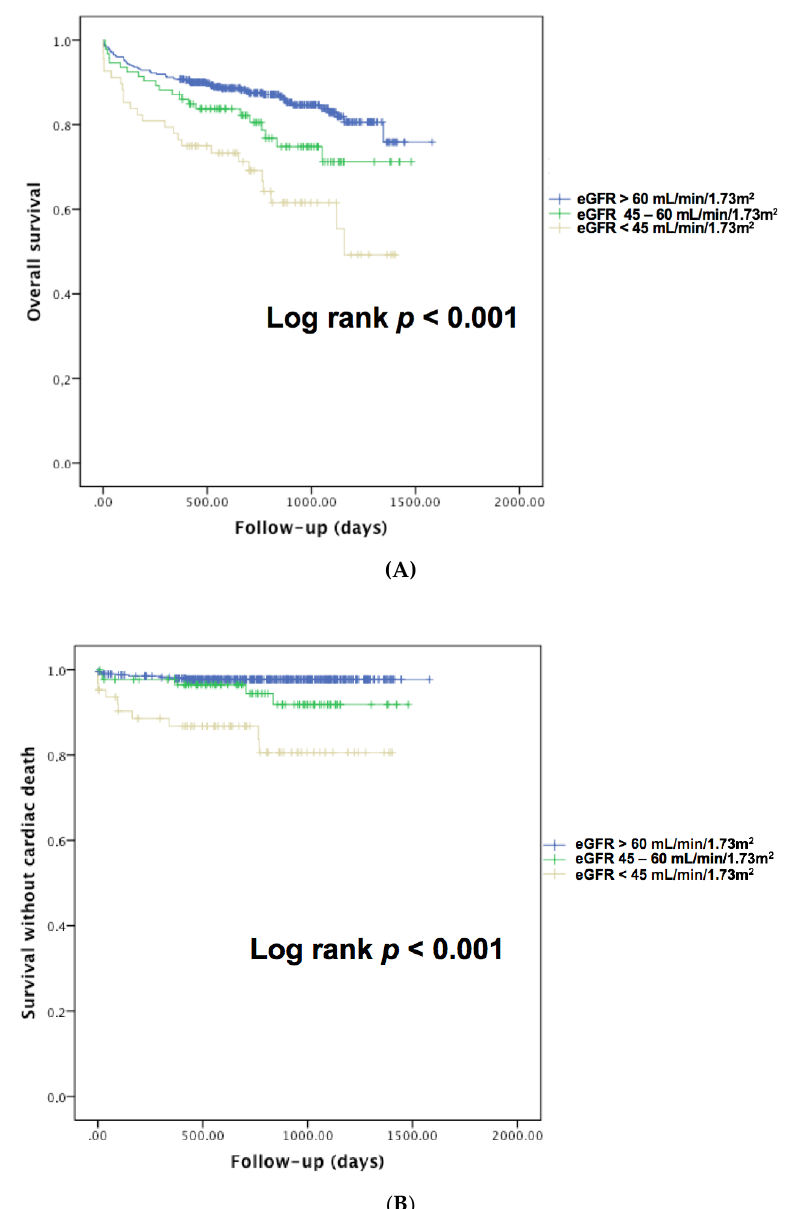
Figure 2. (A) Kaplan–Meier analysis for the probability of overall survival according to renal dysfunction in patients with acute pulmonary embolism. ( B ) Kaplan–Meier analysis for the probability of cardiac survival according to renal dysfunction in patients with acute pulmonary